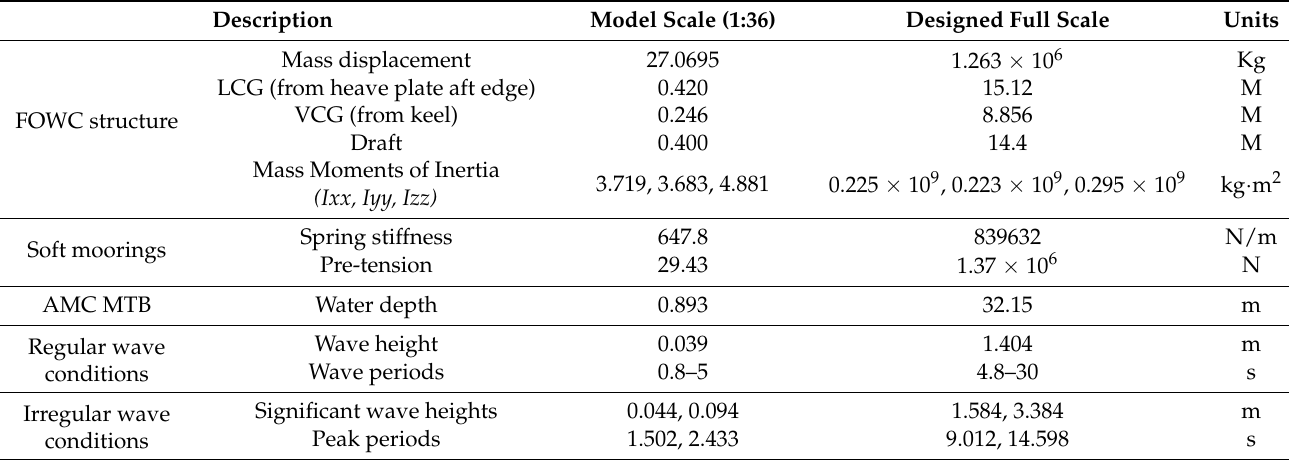
Figure 1. Australian Maritime College’s Model Test Basin (AMC MTB) experimental setup (left), with the main dimensions of the floating oscillating water column (FOWC) model shown on the right side. Table 1. Main particulars of the experimental model and test setup.